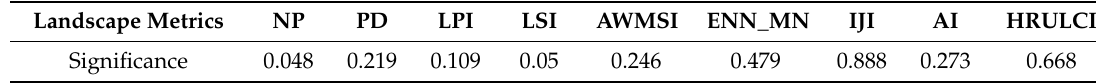
Table 6. The model significance table of pH.